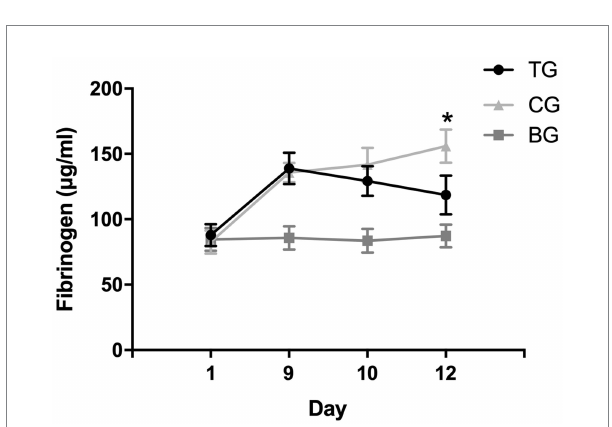
FIGURE 4 Plasma fibrinogen levels after NTG and batroxobin administration. On day 9, the levels of plasma fibrinogen in model rats (TG and CG) were significantly higher than those in BG after recurrent NTG injection, suggesting that recurrent NTG injection increased the levels of plasma fibrinogen. After the batroxobin administration, plasma fibrinogen levels in TG decreased and were significantly lower than CG on day 12, suggesting that two treatments of batroxobin reduced plasma fibrinogen levels in model rats significantly. * p <